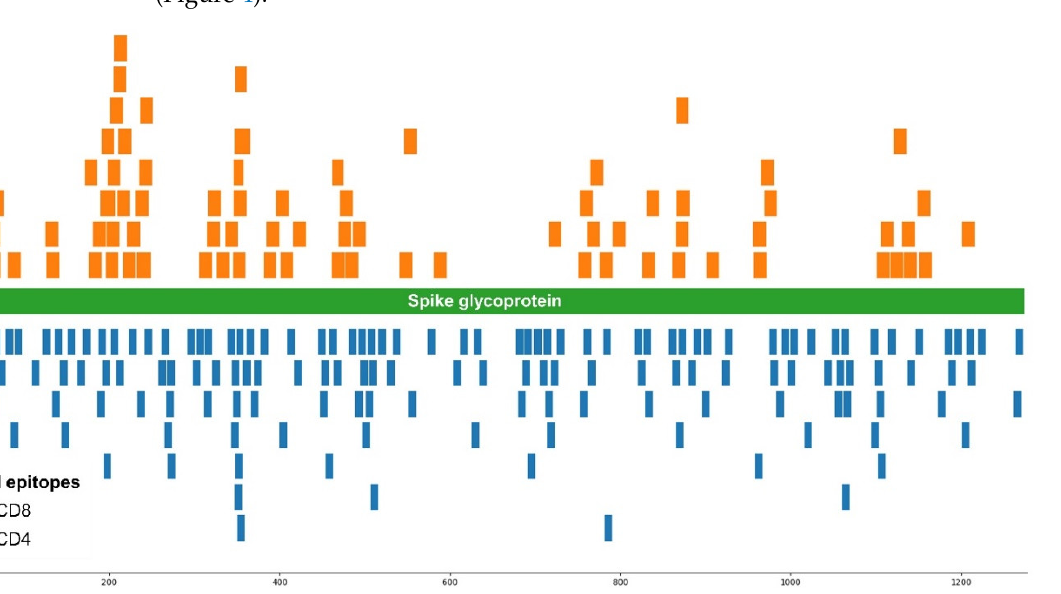
Figure 4. Distribution of spike-specific T cell epitopes. The Figure depicts the location of 152 CD8 (blue bars) and 82 CD4 (orange) T cell epitopes in the primary structure of SARS-CoV-2 spike protein. CD8 and CD4 T cell epitopes were obtained from the Immune Epitope Database resource.